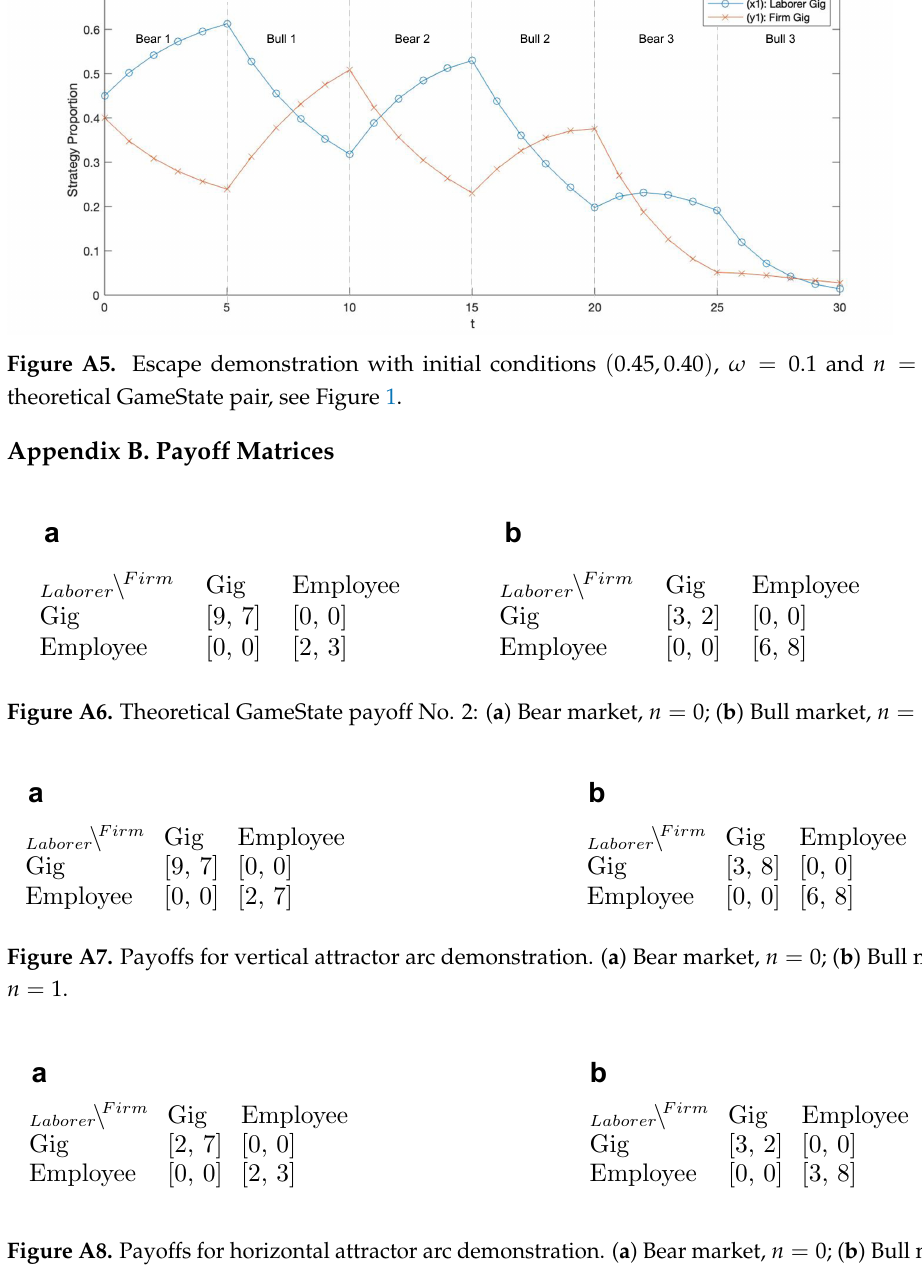
Figure 7: High Employee Payo↵, Matrix Operation